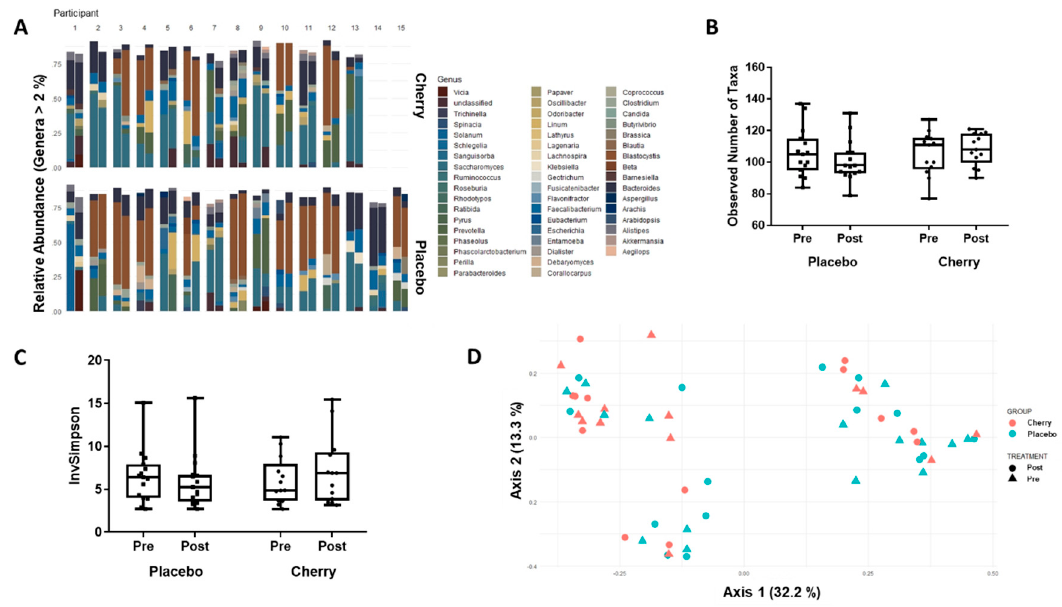
Figure 5. Gut Microbiome in Placebo and Montmorency Cherry Supplemented Middle-Aged Participants. A total of 28 physically inactive and non-obese middle-aged men and women (40–60 years) consumed a daily dose of Montmorency cherry concentrate ( n = 13) or an equivalent volume of glucose and energy-matched placebo ( n = 15) for 4 weeks. Faecal samples were collected pre- and post-supplementation, genomic DNA was isolated and the bacterial microbiome was sequenced. ( A ) Relative abundance of genera of abundance > 2% of the faecal microbiome. Paired bars represent participant microbiome before (left bar) and after (right bar) the intervention. ( B ) Species richness. ( C ) Species diversity—inverse Simpson Index. ( D ) Principal component analysis.